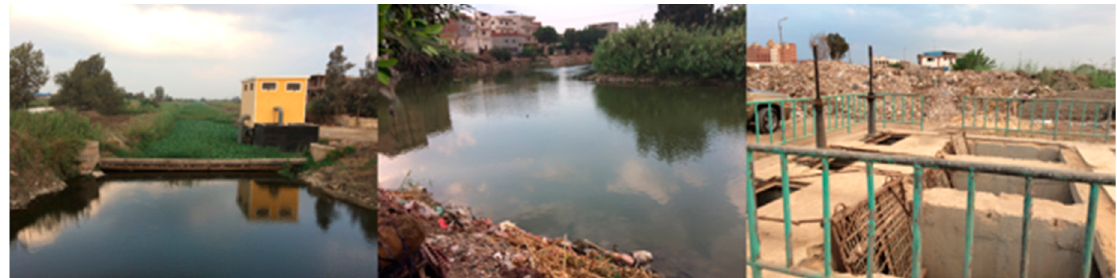
Figure 7. The pump station of Tilla drainage, Kased Canal, and the water plant in Tanta. Source: Author. Legend: The water in the drainage for pumping contains high level of eutrophication ( left ); the bank of canal is covered by solid waste ( middle ); the intake of the water plant is surrounded by garbage heaps ( right ). Location: at 31°06 ʹ 49.9 ʺ N 30°29 ʹ 51.4 ʺ E ( left ), 30°47 ʹ 02.9 ʺ N 30°58 ʹ 24.0 ʺ E ( middle ), and 30°47 ʹ 02.9 ʺ N 30°58 ʹ 24.0 ʺ E ( right ).